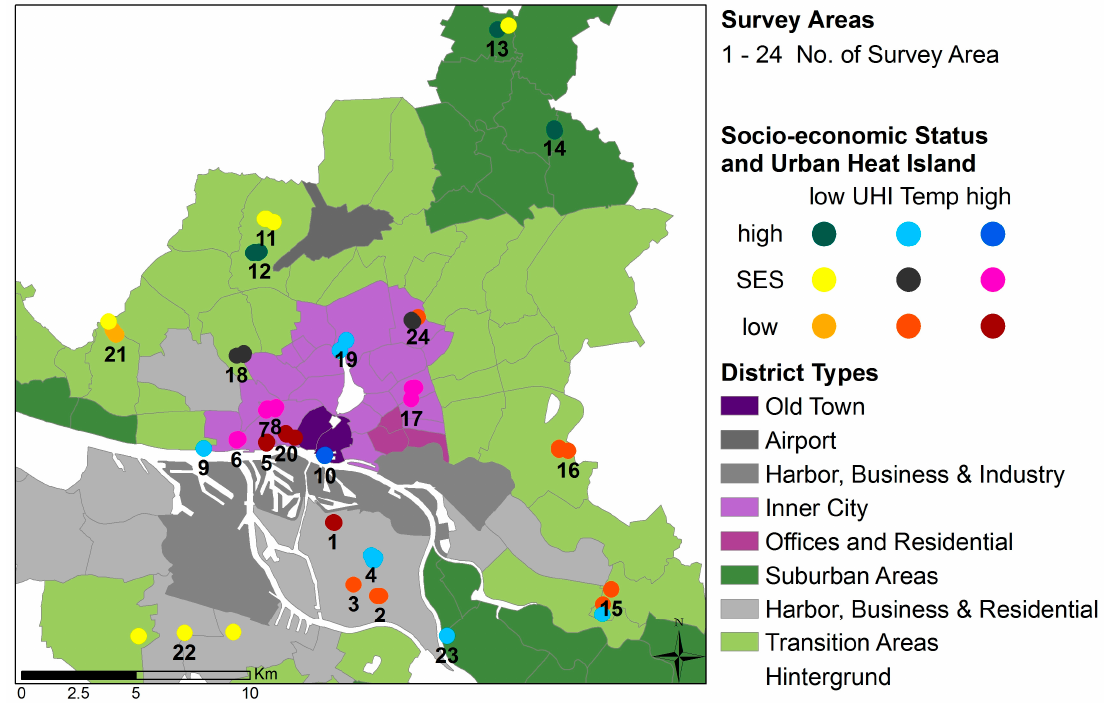
Figure 1. Distribution of survey areas over Hamburg (selection based on data of Steward and Oke [71], Kaveckis [72], Bechtel and Schmidt [69], Boettcher et al. [70], city of Hamburg [73]).